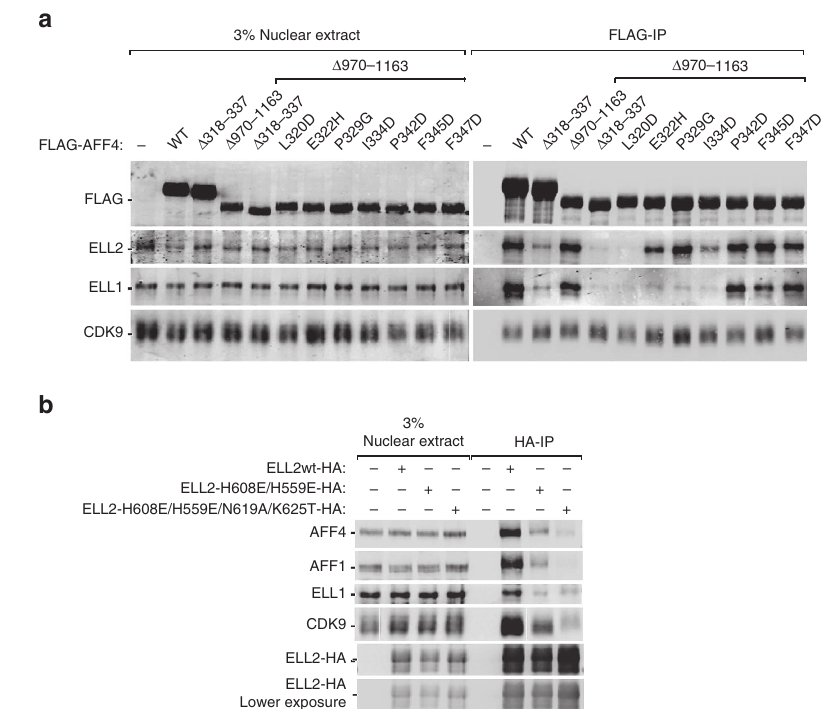
Figure 6 | Role of the ELLBow in AFF4 interactions with ELL1/2 in nuclear extracts. ( a , b ) Nuclear extracts (NE) were prepared from HEK 293T cells transfected with the indicated plasmids and subjected to immunoprecipitation (IP) with anti-FLAG ( a ) or anti-HA ( b ) agarose beads. The NE inputs and IP eluates were examined by immunoblotting for the presence of the various proteins indicated on the left. A shorter exposure of the ELL2-HA panel is also shown at the bottom of b . Uncropped versions of the blots are shown in Supplementary Fig.